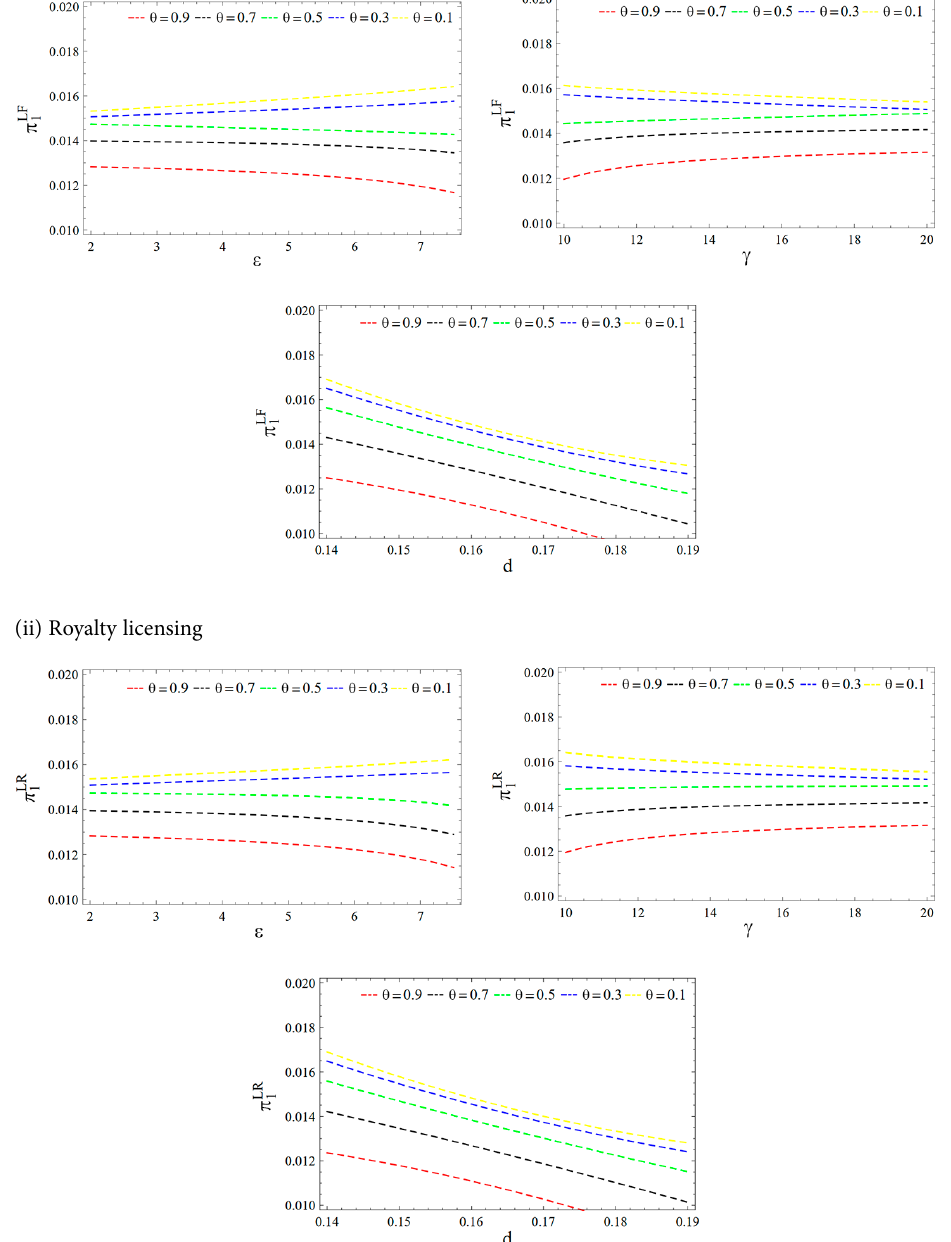
Figure 4. Analytical sensitivity